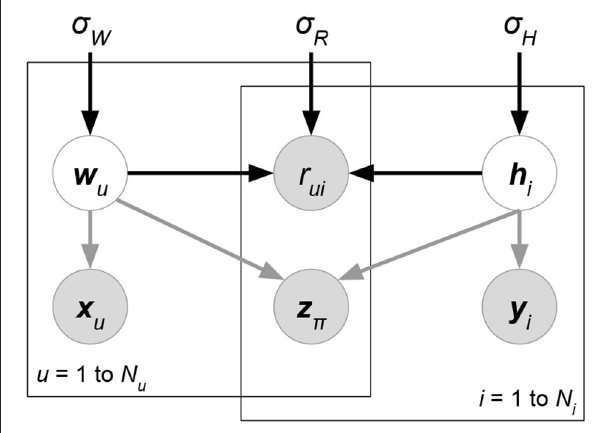
FIGURE 10 | Graphical interpretation of generative probabilistic matrix factorization, whose attributes X , Y , Z , together with ratings, are generated or predicted by latent factors. User and item-relevant attributes X , Y could be generated by corresponding latent factors W , H , respectively. Rating-relevant attributes Z are likely to result from both W and H . For models of this class, some of the gray arrows are removed to represent their additional independence assumptions about attribute